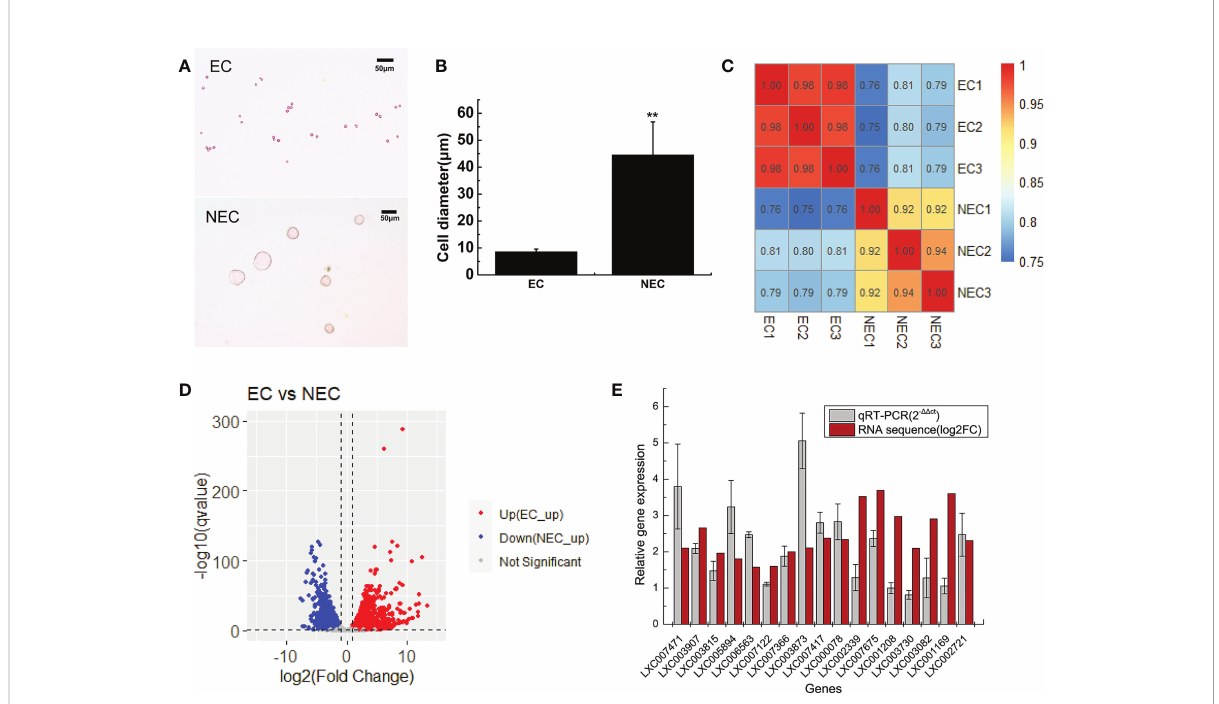
FIGURE 2 Transcriptome analyses of ECs and NECs of G. lemaneiformis . (A) Single cells of ECs and NECs. (B) Diameter of ECs and NECs. “ ** ” indicated statistically signi fi cant differences by Student ’ s t-test (p < 0.01). (C) Correlation plot of gene expression levels in ECs and NECs. The numbers in boxes represented Spearman correlation coef fi cient of the corresponding two samples. (D) Volcano plot of the DEGs levels in ECs and NECs. (E) Validation of gene expression of some DEGs by qRT-PCR. Log2(fold change) represents logarithmic value of the change in expression of NEC vs